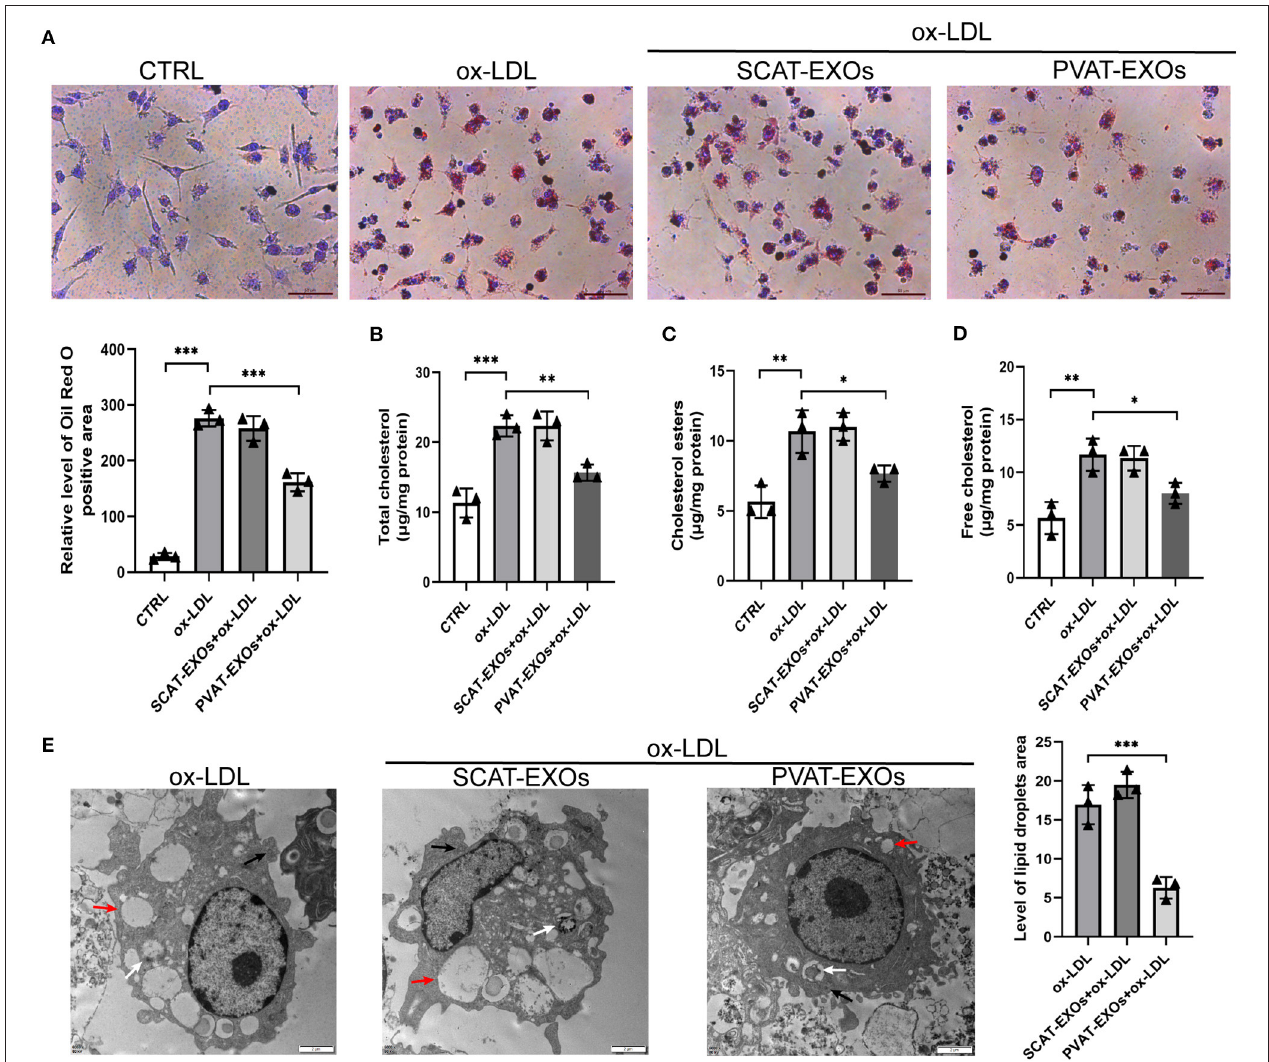
FIGURE 3 | PVAT-EXOs reduced macrophage foam cell formation. RAW264.7 cells were incubated with SCAT-EXOs, PVAT-EXOs or equal amounts of PBS and then incubated with or without ox-LDL. Oil Red O staining indicated that PVAT-EXOs reduced macrophage foam cell formation (A) . Scale bars: 50 µ m. Lipid accumulation in macrophages was confirmed by determining the levels of total cholesterol (B) , cholesterol esters (C) and free cholesterol (D) . Ctrl: control group. The ultrastructure of foam cells was detected with transmission electron microscopy (E) . Black arrows indicate phagosomes, white arrows indicate lysosomes, and red arrows indicate lipid droplets. Scale bars: 2 µ m. * P < 0.05, ** P < 0.01, *** P < 0.001 vs. the ox-LDL treated group.